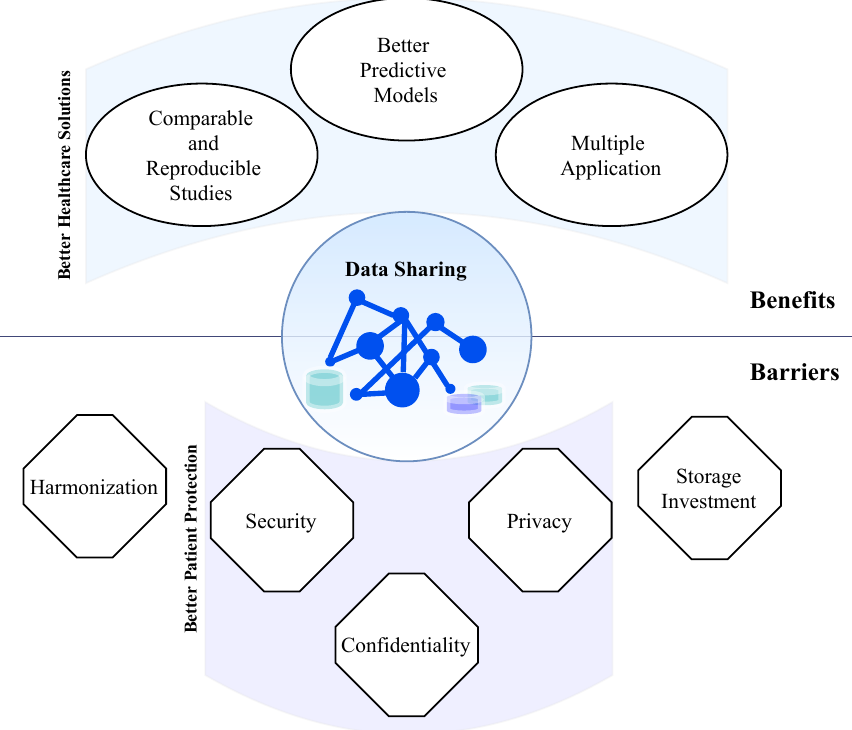
Figure 1. Representation of main benefits and barriers of data sharing. Data sharing has several bene- fits for healthcare solutions development. Some of the main barriers to data sharing are fundamental for patient data